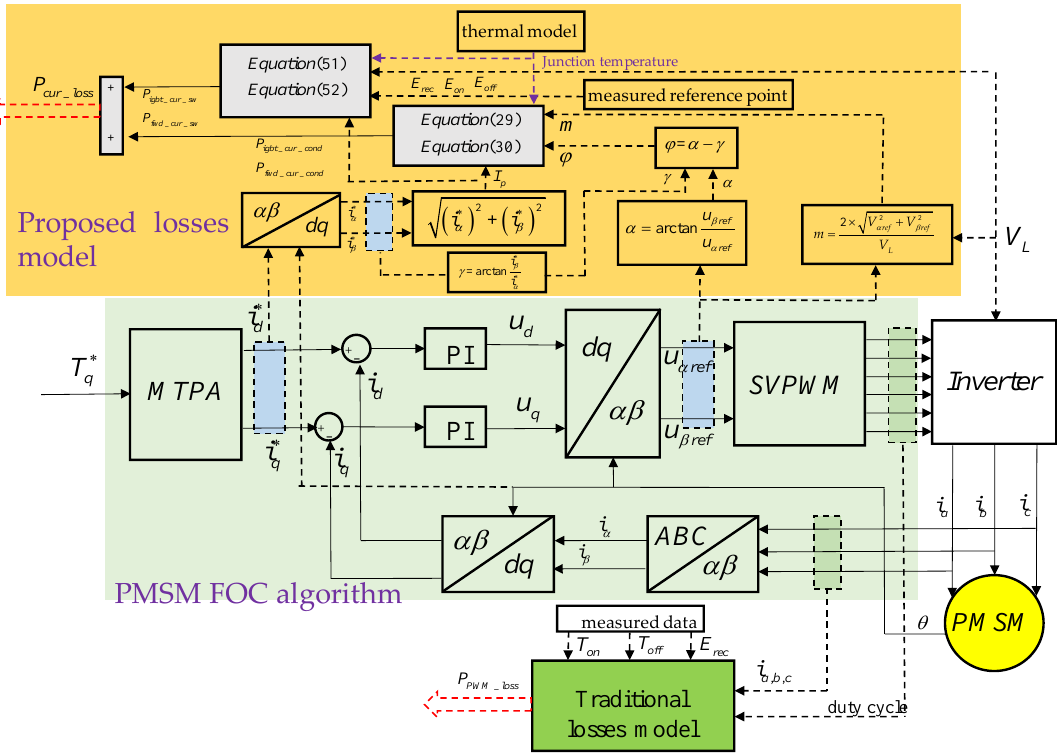
Figure 8. Comparison between the proposed losses model and the traditional losses model.